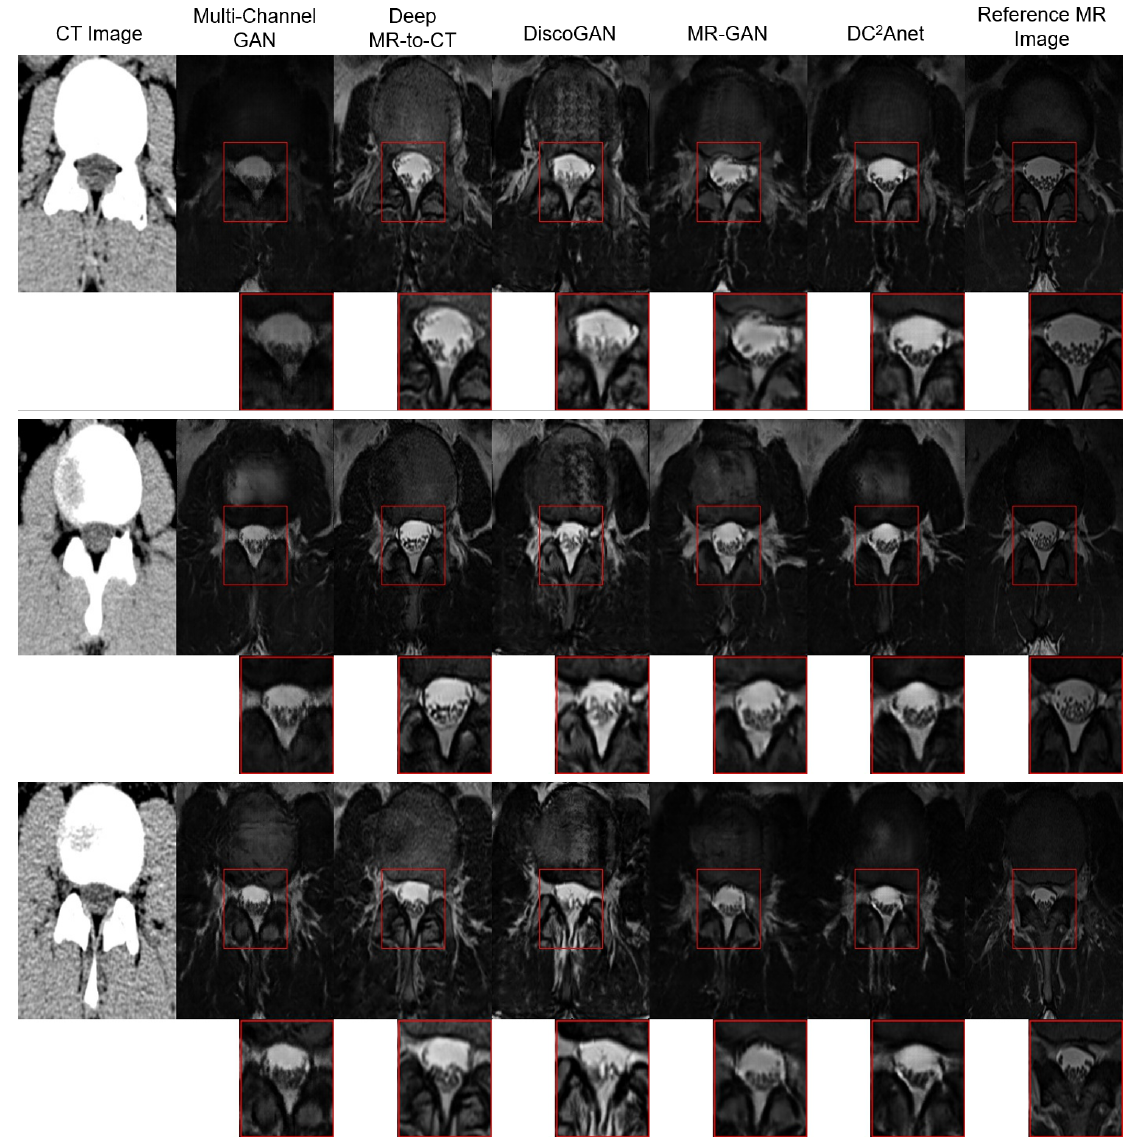
Figure 8. Qualitative comparisons of DC 2 Anet and baseline methods. Rows 1, 3, and 5 show CT images, synthetic images, and the reference image. Rows 2, 4, and 6 show the enlarged spinal cord of the corresponding images. From left to right: input CT image, synthesis MR images from multi-channel GAN [33], deep MR-to-CT [41], DiscoGAN [44], MR-GAN [45], the proposed DC 2 Anet, and the reference MR